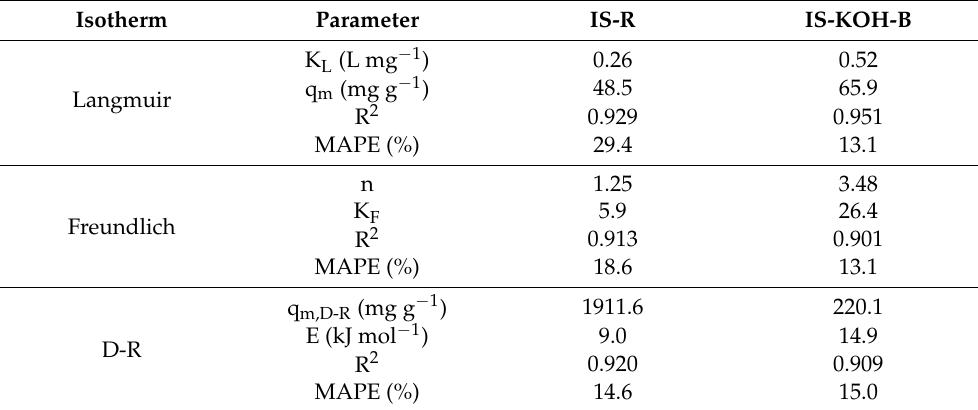
Table 3. Isotherms parameters regarding MB adsorption by raw industrial sludge and its KOH activated biochar.